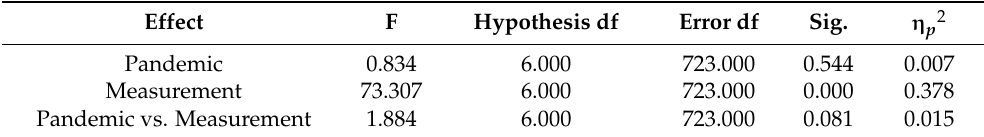
Table 6. Significance values and effect size of the variables of the initial–final measurements vs. the